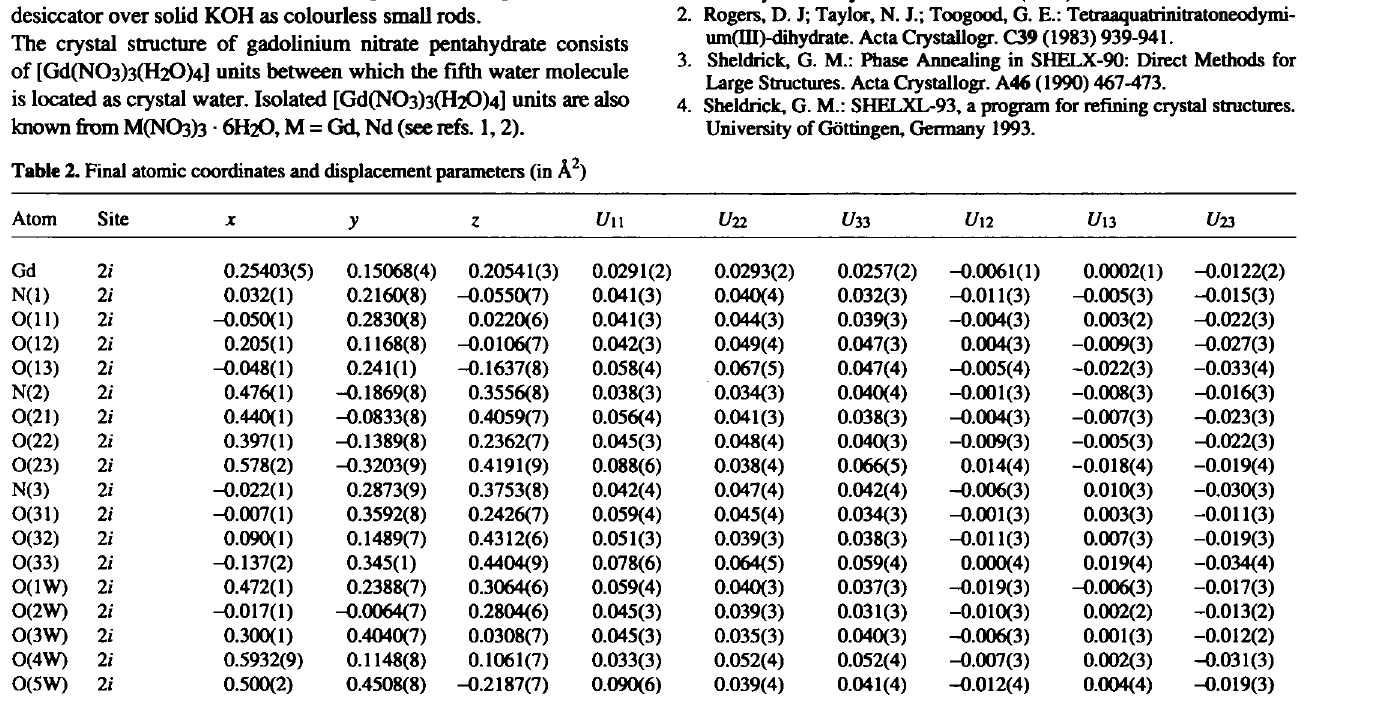
Table 2. Final atomic coordinates and displacement parameters (in Â 2